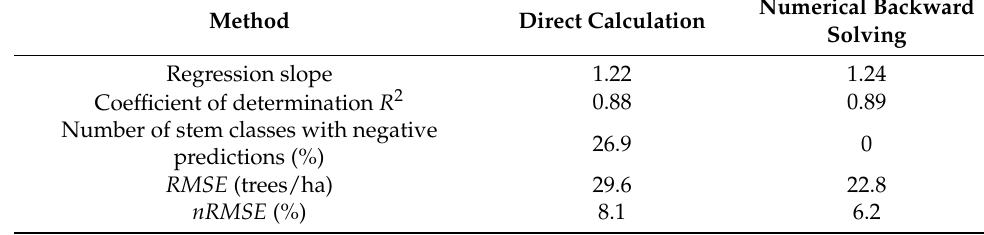
Table A1. Results of different calculations (direct: calculation of stem numbers N from Equation 11, numerical backward: numerical solving of Equation 10 for stem numbers N , see methods and